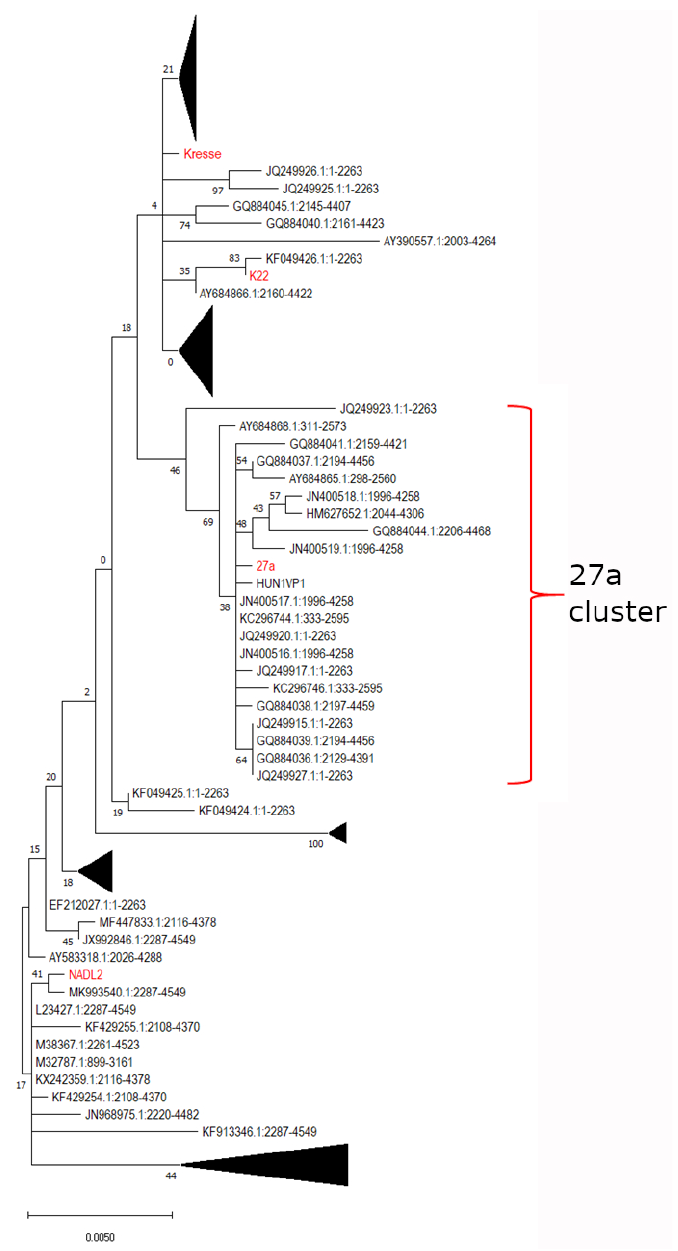
Figure 1. Phylogenetic tree of the full-length VP2 DNA sequence of 93 PPV isolates. The tree was constructed with the Mega X program (version 10.2.6.) using the maximum likelihood method with the Tamura–Nei model. Numbers indicate bootstrap values in percentage. Some branches of the tree are collapsed for a more visible representation. A few representative strains are highlighted in red.